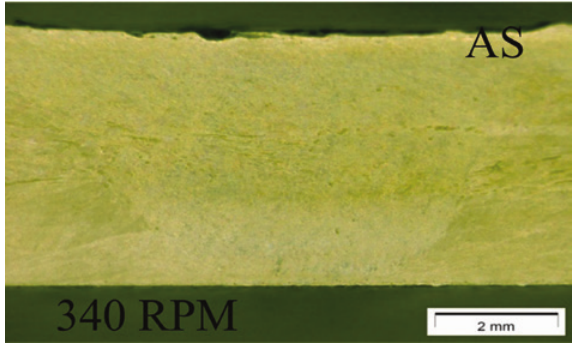
Figure 1: Optical macrograph of bead on plate welded AZ31B-O Mg alloy plate cross section sample at 340 rpm.